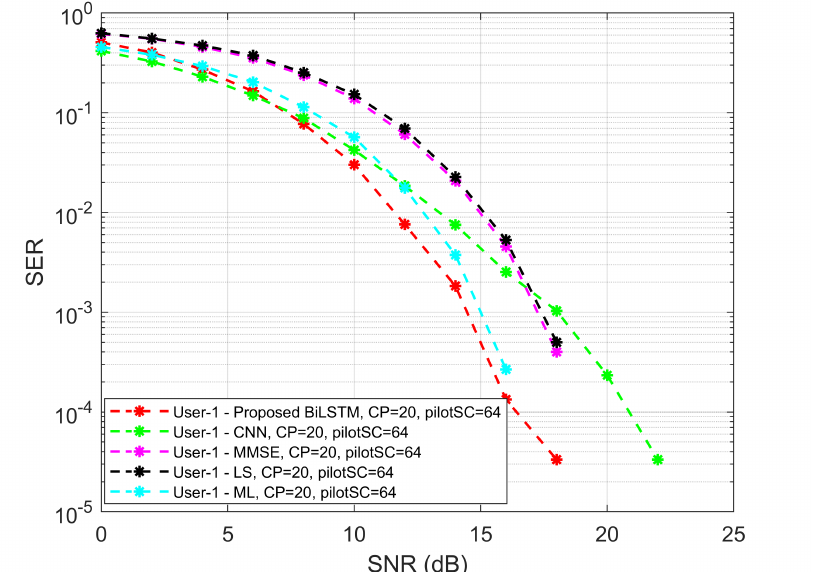
Figure 11. SER versus SNR performance comparison for UE 1 of the proposed method against CNN, LS, MMSE, and